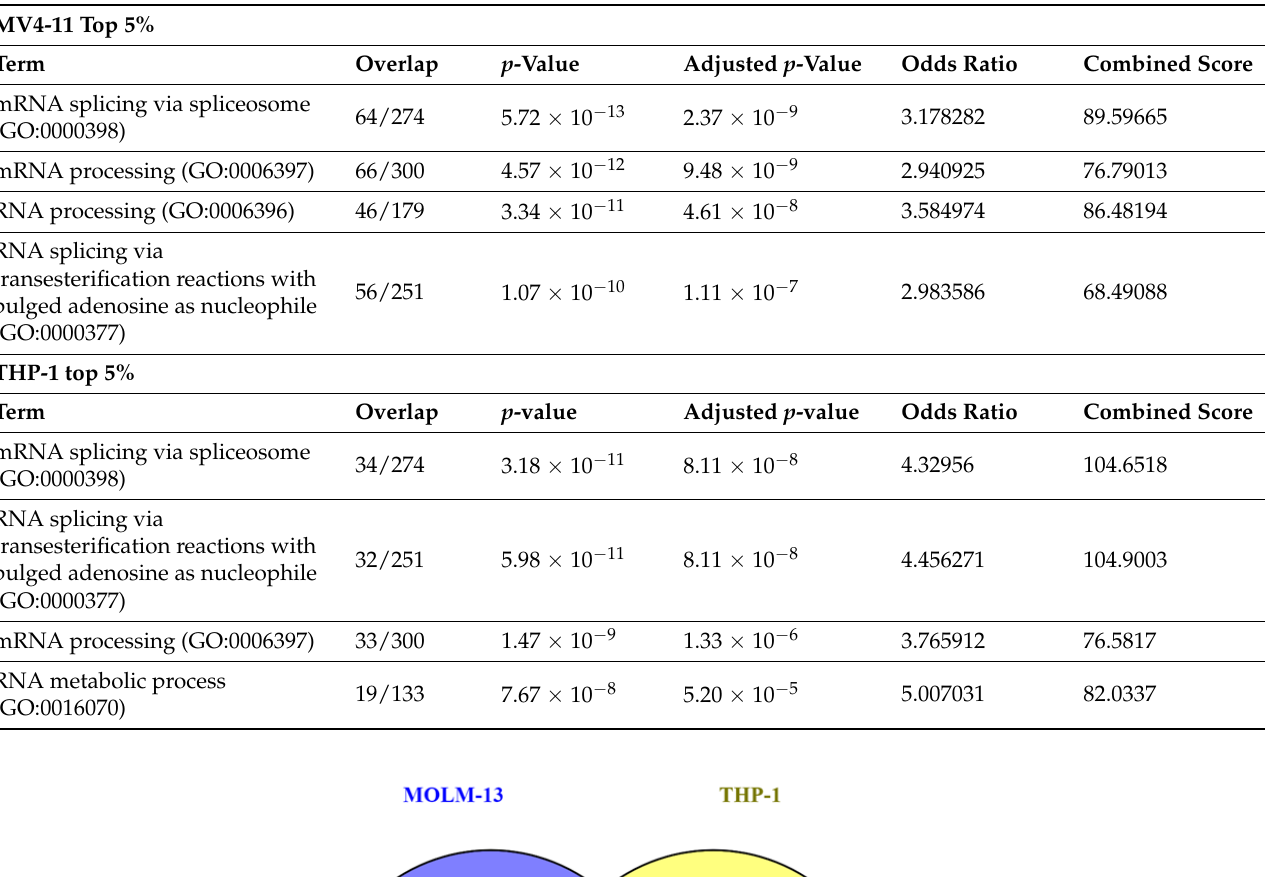
Table 3. GO terms (biological processes) for genes with the broadest H3K79me2 domains in AML cell lines.